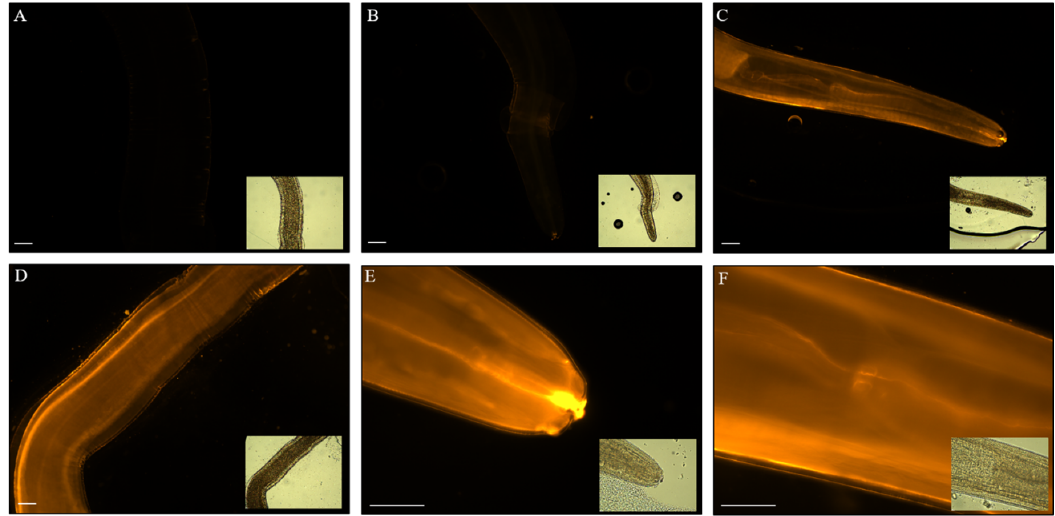
Figure 2. Anisakis spp. L3 cultured for 16 h in the presence of 0 µ M ( A ), 1 µ M ( B ) or 4 µ M ( C – F ) DOPE-Rho prior to washing, fixation with 4% paraformaldehyde and analysis using fluorescence microscopy. Orange = Rhodamine, Scale bar: 100 µ m. Corresponding bright-field images are